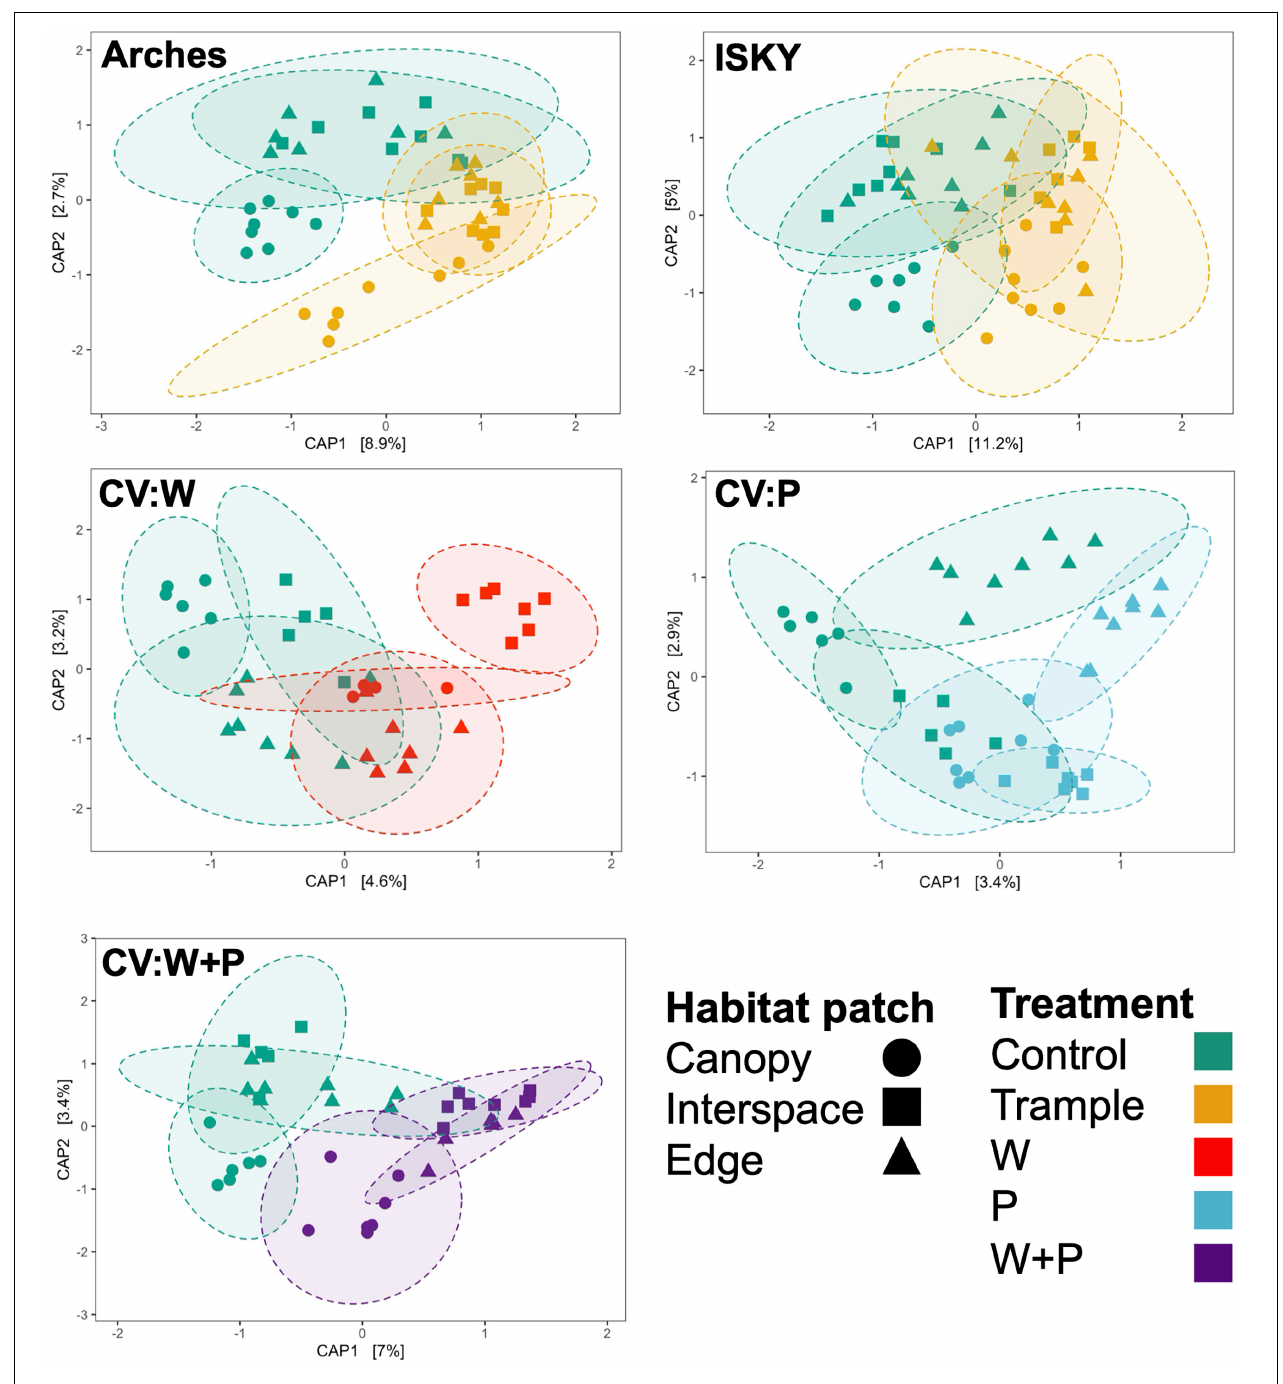
FIGURE 5 | Influence of habitat patch on community composition. Canonical analysis of principal coordinates ordination of sequence datasets for each treatment. Axes labels denote the percent variation explained by principal components. Ellipses indicate the 95% confidence interval of the group centroids. A table of PERMANOVA statistical results of between group comparisons is presented in Supplementary Table 3